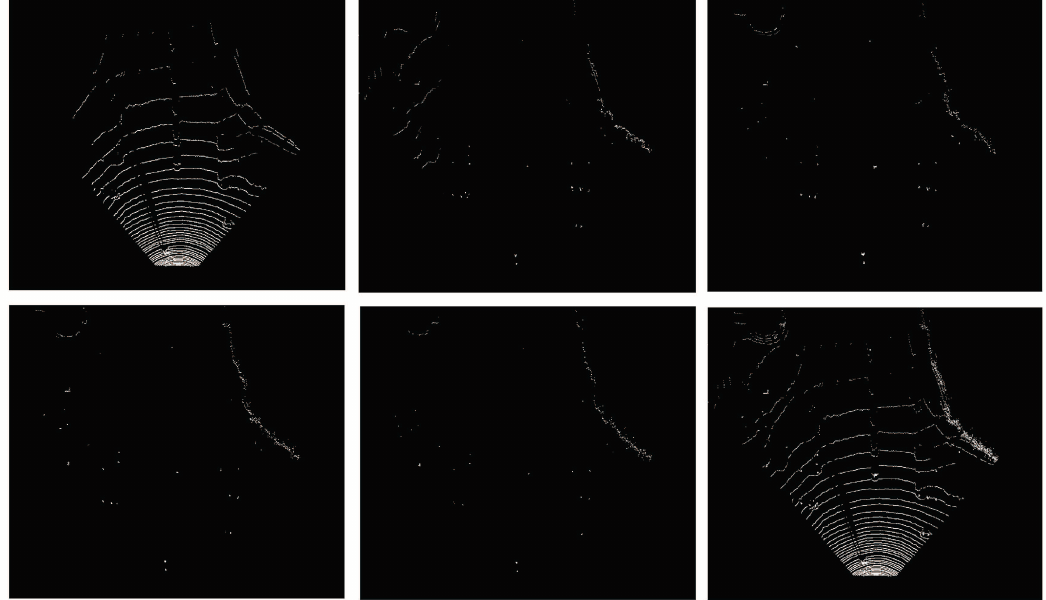
Figure 2. From top to bottom and left to right are the six channels of